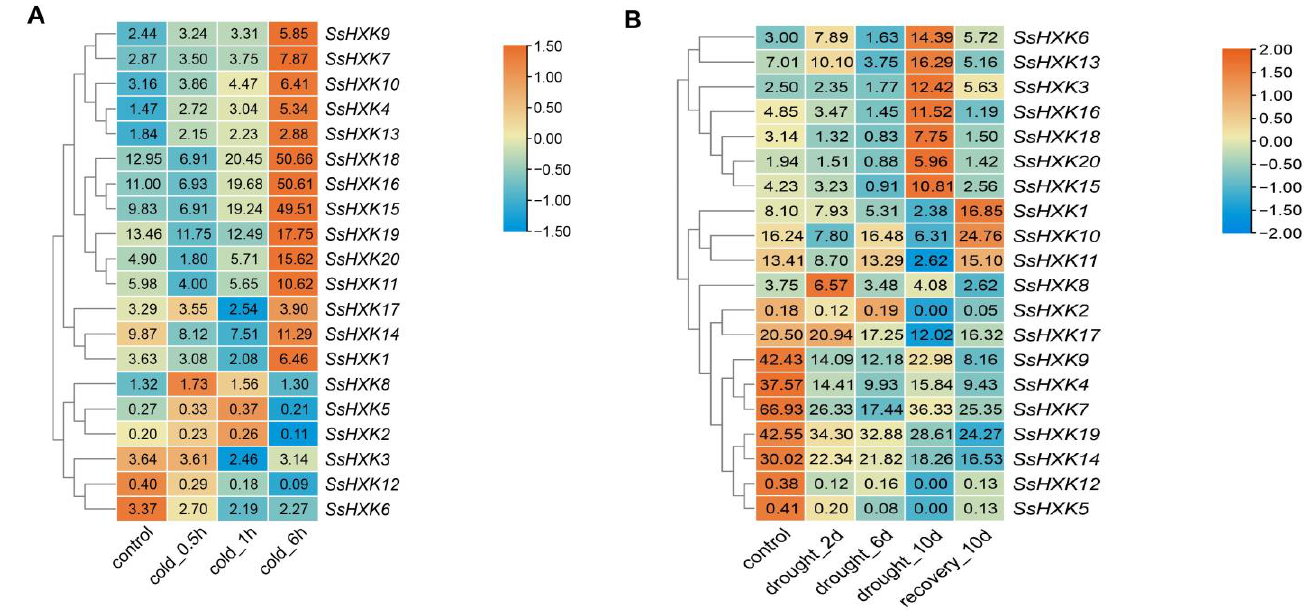
Figure 8. Expression profiles of SsHXKs based on SRA data. ( A ) Sugarcane stressed by cold. ( B ) Sugarcane stressed by drought. The number shown in the box is the original trimmed mean of M-values (TMM) which represent the expression levels of SsHXKs . The color bar represented the row scale normalized values.